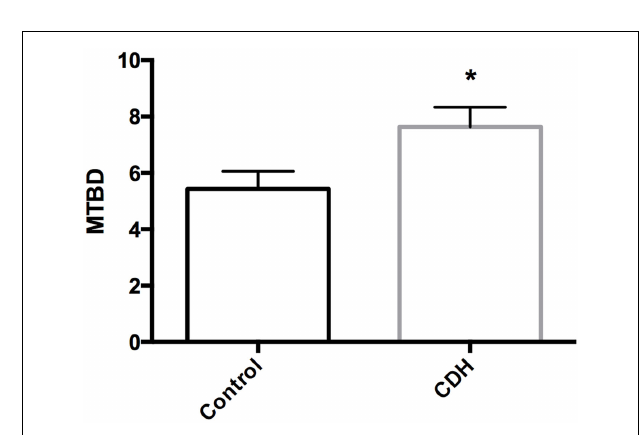
FIGURE 1 | (A) Total lung weight and (B) lung to body weight ratio in CDH ( n = 3) and control ( n = 5) lambs following delivery at 136days gestation. CDH lung weight (A) and lung to body weight ratio (B) were both significantly lower in the CDH sheep (* p < 0.05, ** p < 0.01).